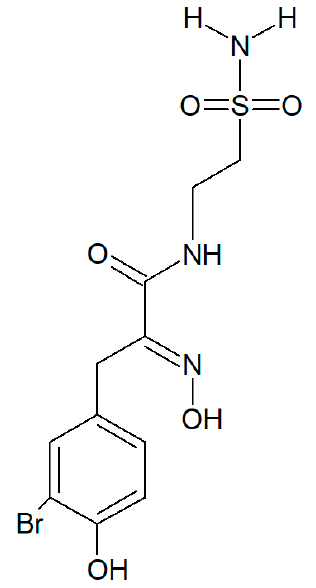
Figure 6. Structure of psammaplin C.